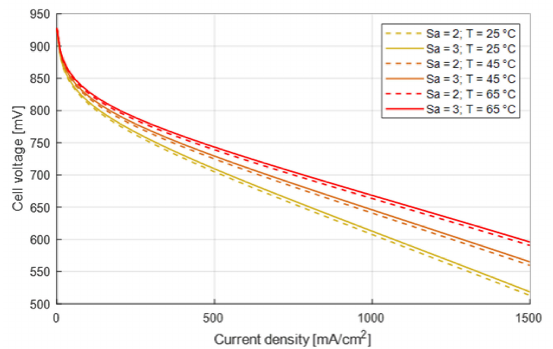
Figure 2. Cell current-voltage polarization curves for different values of operating temperature and air ratio to